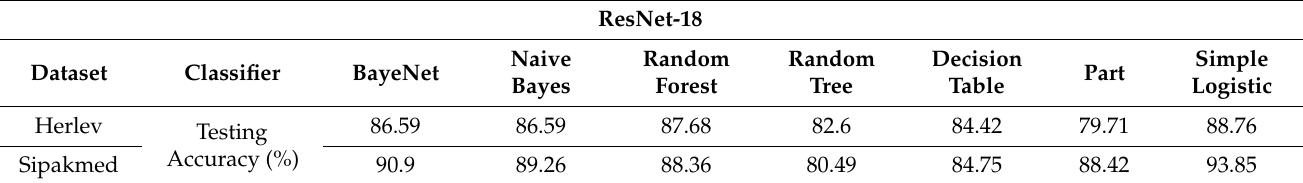
Table 8. Classification accuracy of ResNet-18 model with machine learning classifiers.